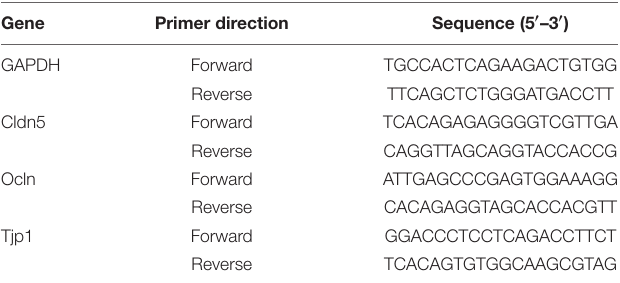
TABLE 1 | Oligonucleotide primer sequences for